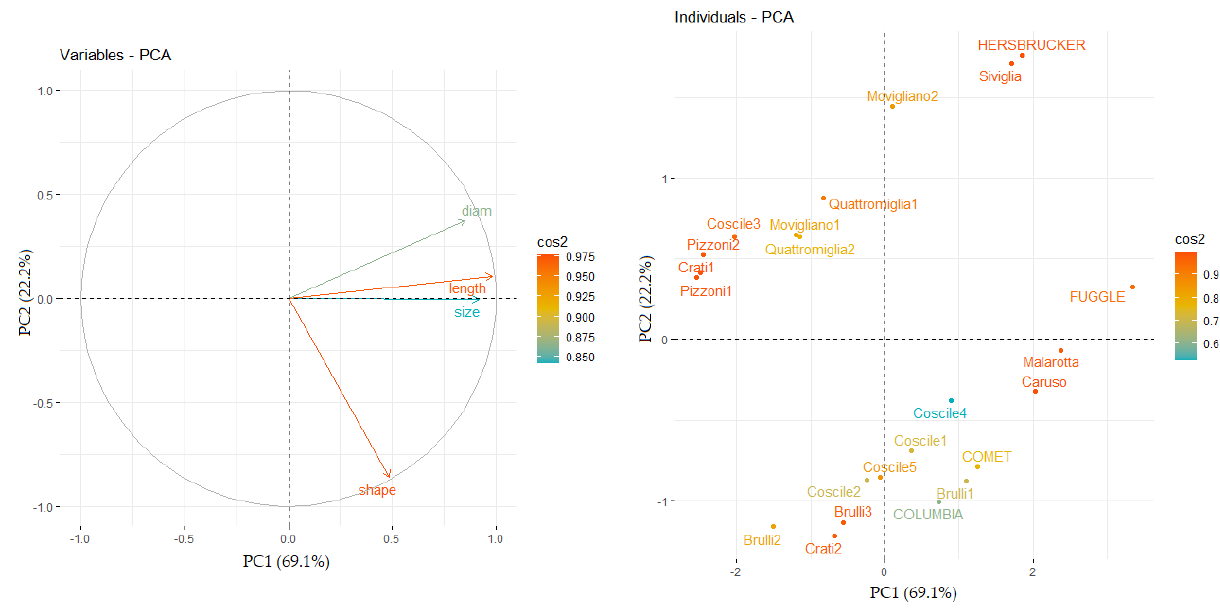
Figure 2. Principal coordinates analysis (PCoA) of 23 Calabrian hops populations based on agro-morphological traits (length = cone length; diam = cone diameter; size = cone size; shape = cone shape).